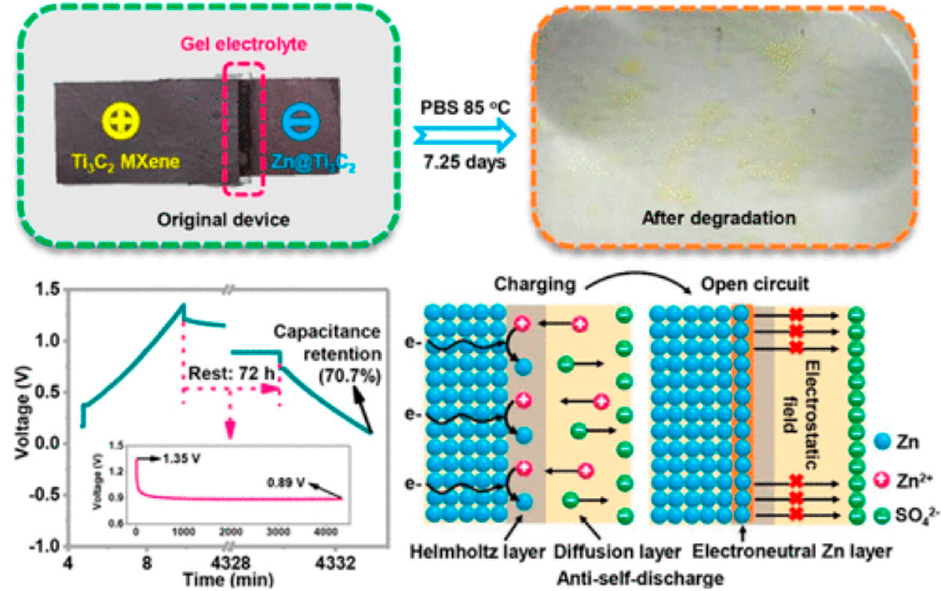
Figure 28. ( Top ) Anode and cathode of the gel capacitor device, with Ti 3 C 2 as anode and Zn@Ti 3 C 2 as cathode, before then after ( right ) degradatio in PBS at 85 °C during a week. ( Bottom ) Charge–discharge curves ( left ) and schematized functioning ( right ). Reproduced from [120]. Copyright 2019 American Chemical Society.